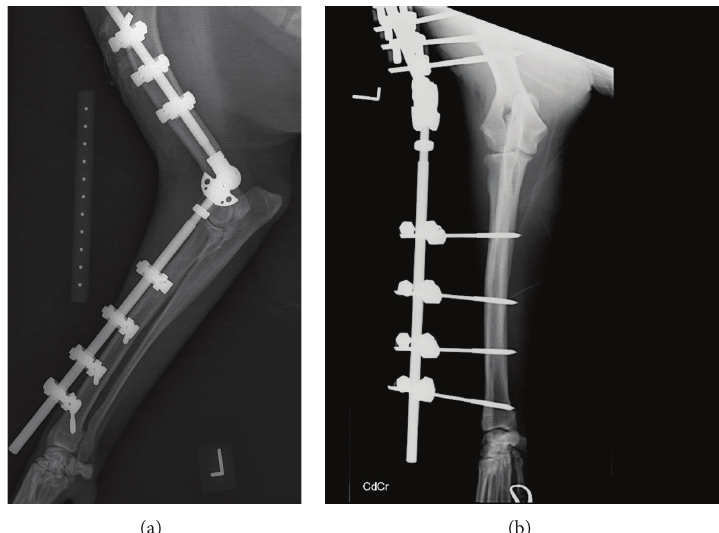
Figure 3: (a) Mediolateral radiograph of the left forelimb after reduction and stabilisation of left elbow. (b) Caudocranial radiograph of the left forelimb after reduction and stabilisation of left